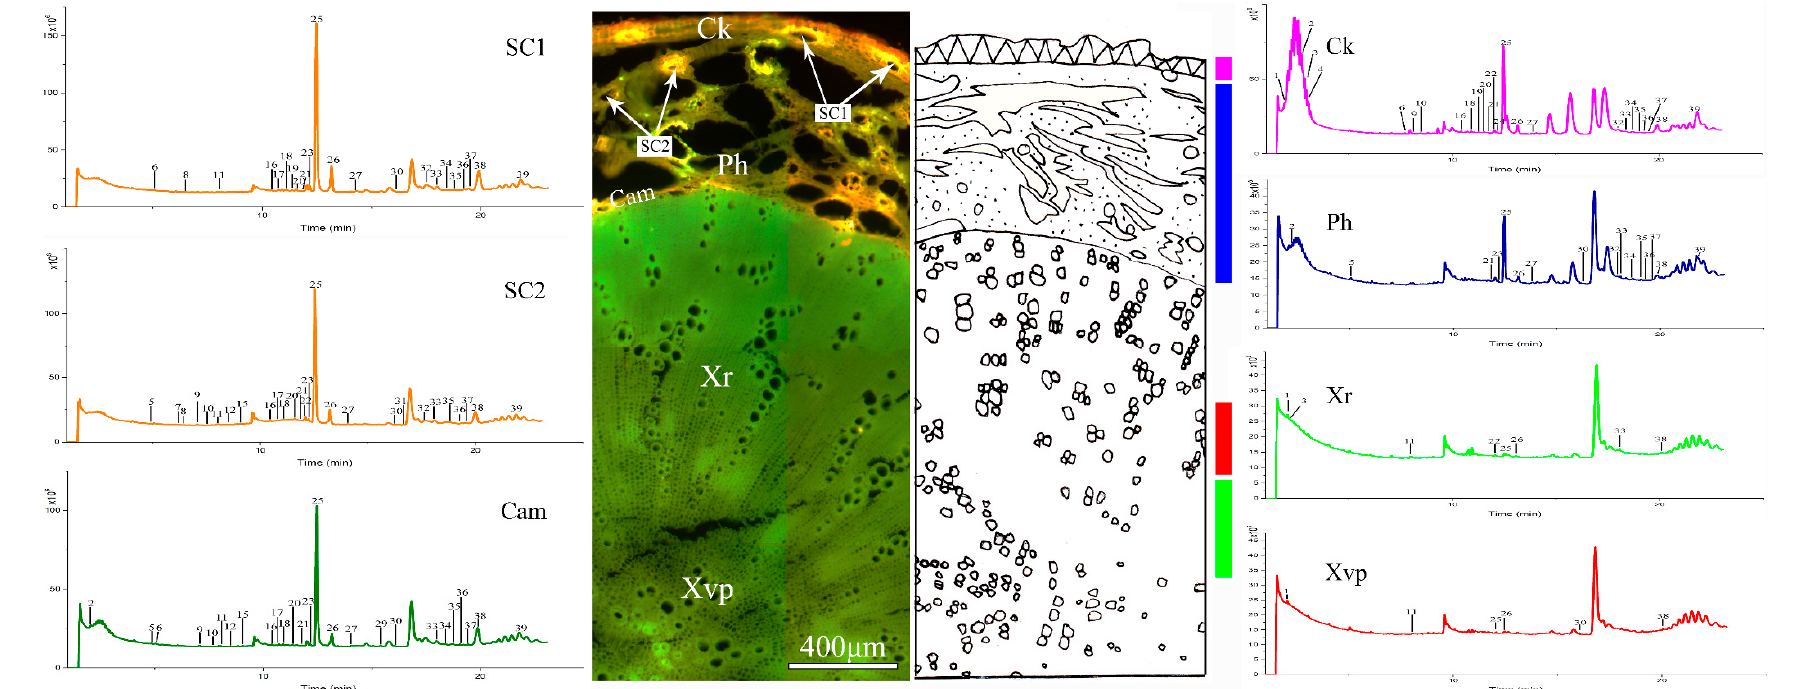
Figure 4. LC–MS base peak chromatograms of microdissected tissues from Xiong Qianhu (Sample 9). The peak numbers referred to Table 1. SC1, secretory canals 1; SC2, secretory canals 2; Cam, cambium; CK, cork; Ph, secondary phloem; XR, xylem ray; Xvp, xylem vessels and parenchyma cells.